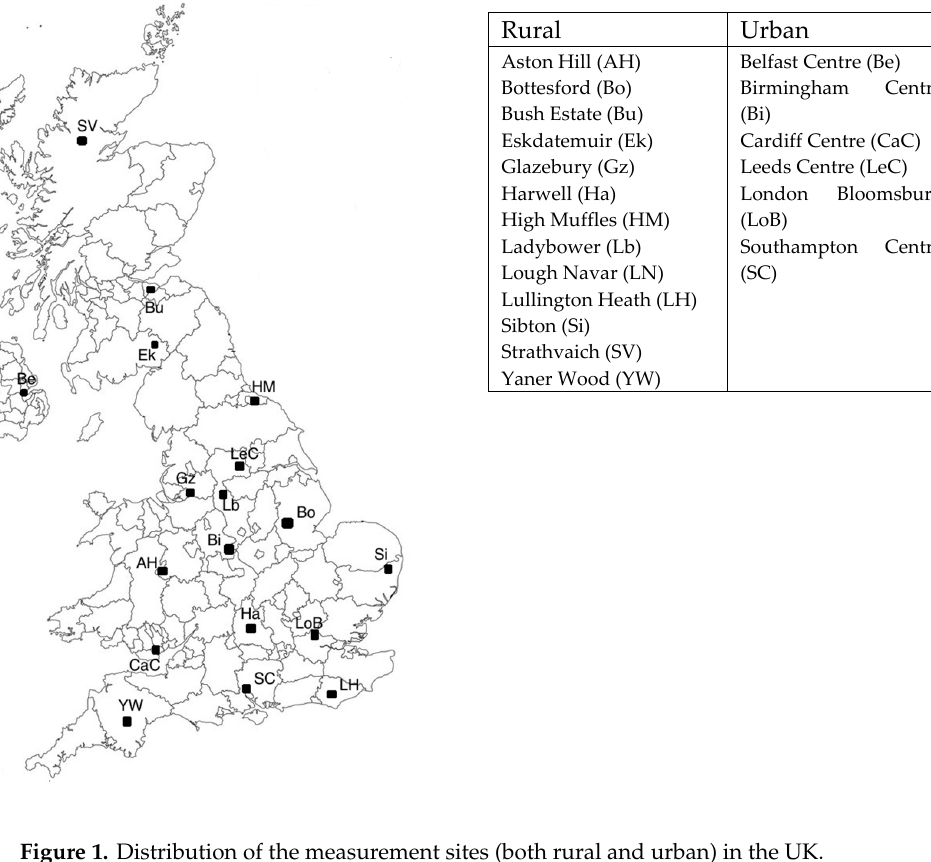
Figure 1. Distribution of the measurement sites (both rural and urban) in the UK.